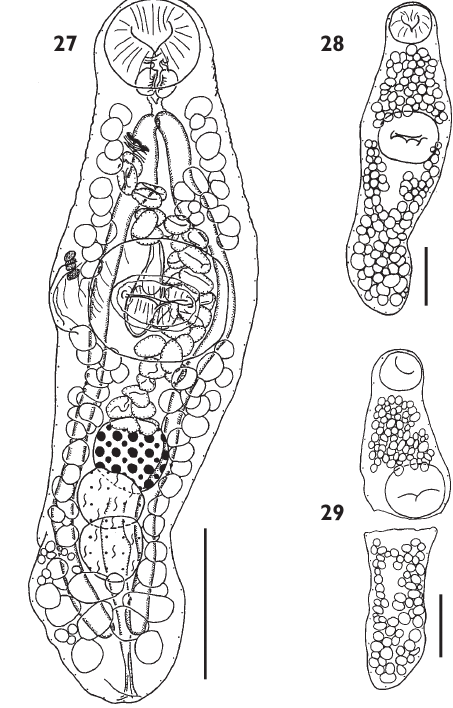
Figs 24-26. Macvicaria dextrocaula n. sp. ex Noto- labrus parilus . 24. Whole-mount ventral view. 25. Whole-mount lateral view. 26. Terminal